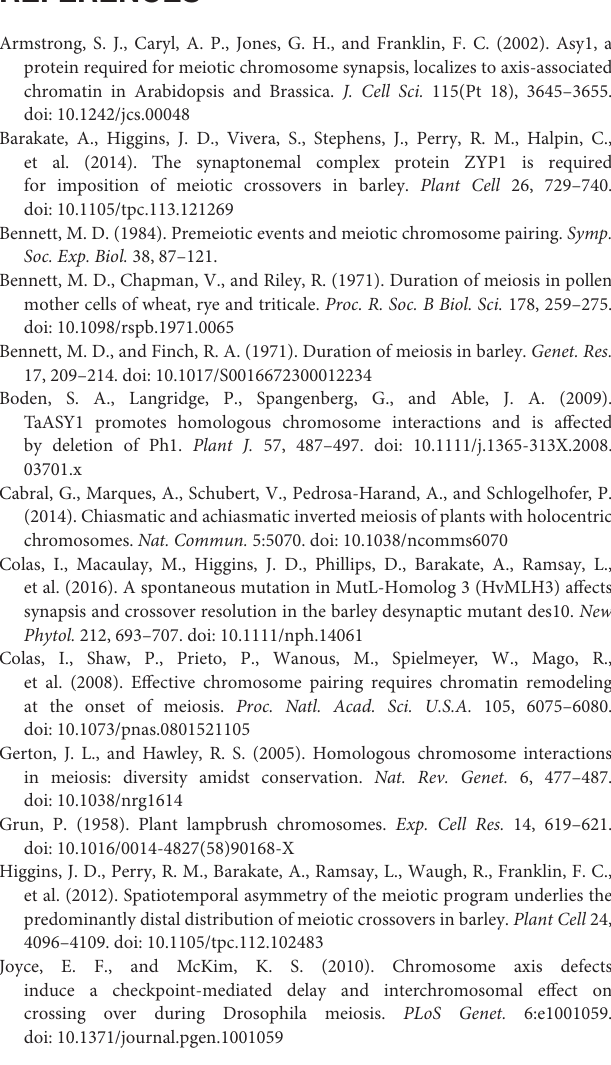
labelling at diplotene (o,t) (dissolution of synapsis) is very fragmented and patchy. Scale bar 5 µ m. Supplementary Figure 3 | OMX details of Figure 1 . Synapsis is followed in detail with 3D-SIM using ASY1 (green) and ZYP1 (magenta) for barley (a–h) and wheat (i–p) . Synapsis starts at leptotene (a,e) . In barley the tripartite structure of the SC becomes visible at zygotene ( b,f , arrow). At late pachytene, small loops of ASY1 are evident ( c,g , arrow), that may represent the initial formation of the larger loops at later stages ( d,h , arrow). In wheat, synapsis start similarly to barley (I,m) but the SC tri-partite structure is not obvious along the bivalents (j,n) but is partially evident during pachytene ( k,o , arrow). At diplotene (l,p) , wheat also forms tinsel like structures. White boxes indicate zoomed area. Supplementary Figure 4 | Gallery image of wild type barley tinsel structure. The DAPI (blue) labeled chromatin shows the individual thick bivalents during diplotene. When navigating through the section, we can see that ASY1 (green), ZYP1 (magenta) are embedded within the DAPI signal and thus within the chromatin. Supplementary Video 1 | 3D wheat Leptotene with ZYP1 (magenta) and ASY1 (green).